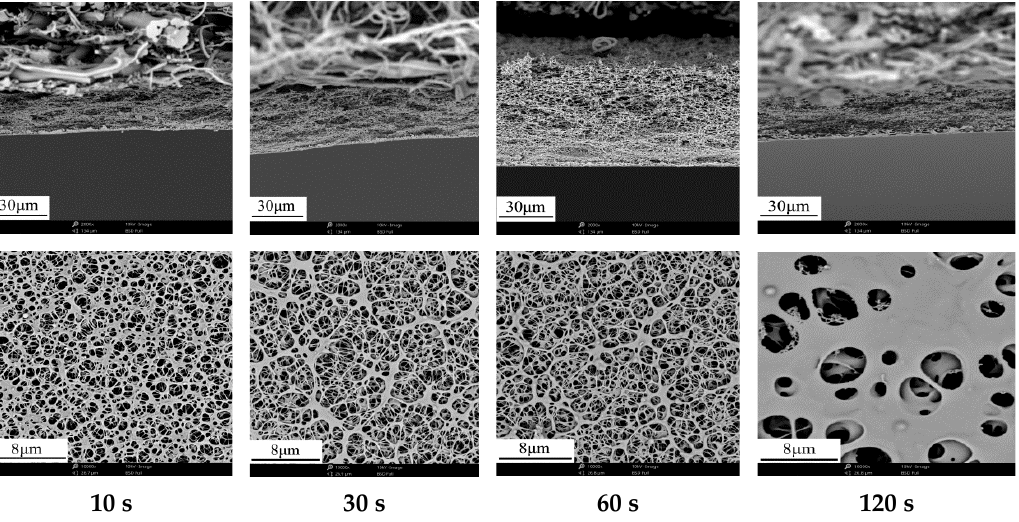
Figure 6. Effect of evaporation time on the cross-section and surface microstructure of membranes. Table 7. The properties of membrane prepared under different evaporation time.